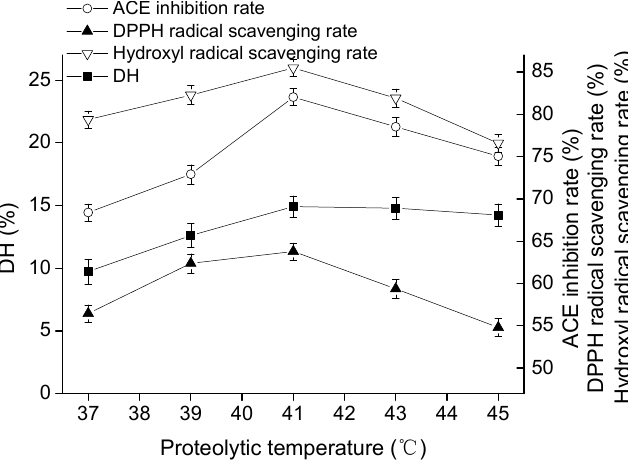
Figure 2. Effect of proteolytic temperature on DH, ACE inhibitory activity, and antioxidant activity of hydrolysate at pH of 8, time of 4 h, and E / S of 10% ( w / w ). The error bars represent standard deviation of means ( n = 3).